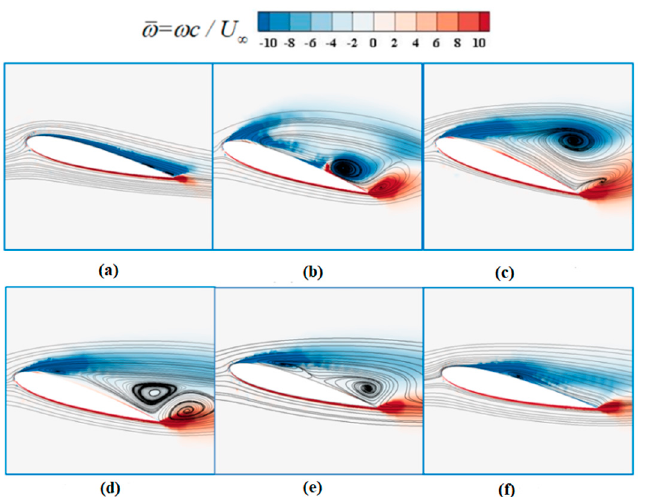
Figure 7. Vorticity with streamlines for different angles of attack. ( a ) 14t ↑ ( b ) 18 ° ↑ ( c ) 20 ° ↑ ( d ) 17 ° ↓ ( e ) 15 ° ↓ ( f ) 13 ° ↓ .